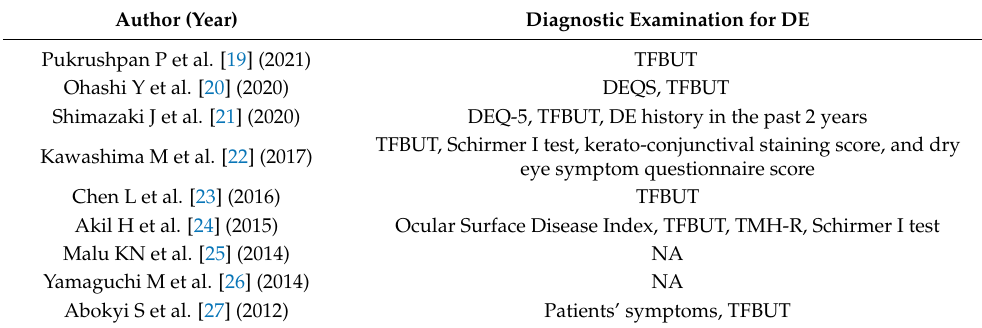
Table 3. Diagnostic examinations for